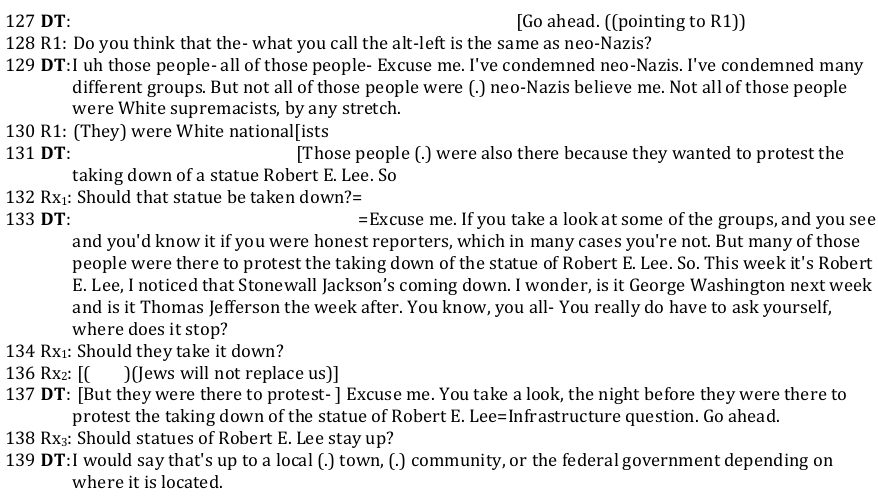
Figure 13. Transcript excerpt 127–139.